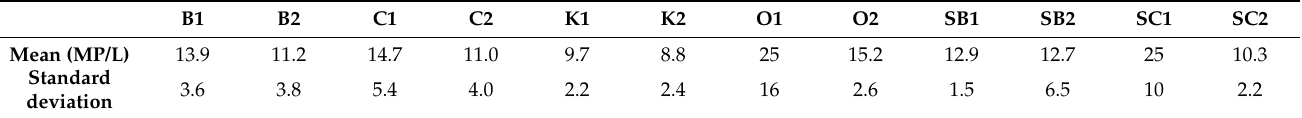
Table 4. Mean microplastic concentration (MP/L) and standard deviation at a site-specific level. Table 3. Mean microplastic concentration (MP/L) and standard deviation at a catchment level.